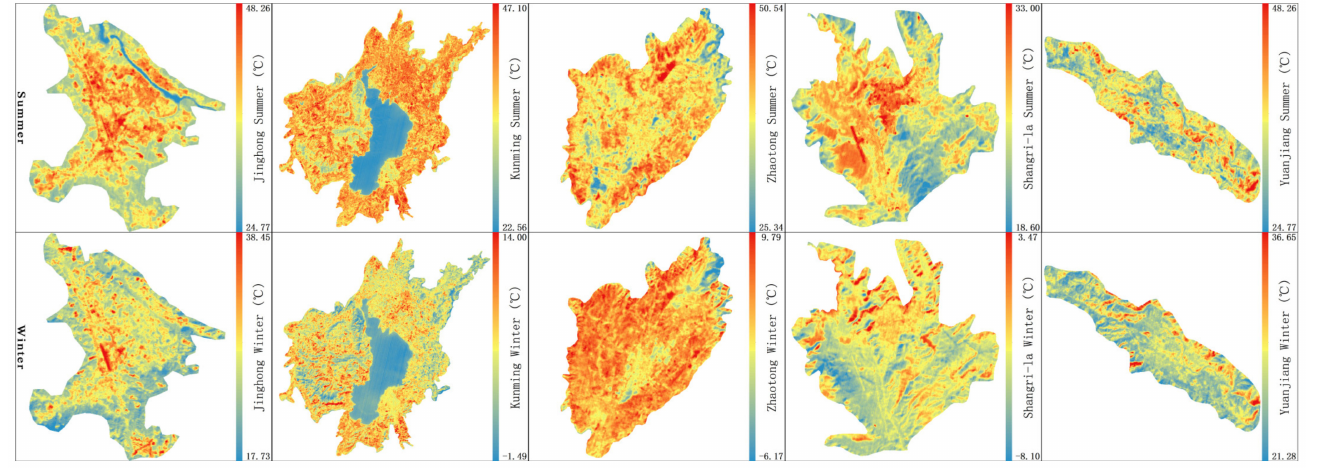
Figure 4. LST values in summer and winter in the cities with different background climates (units: ◦